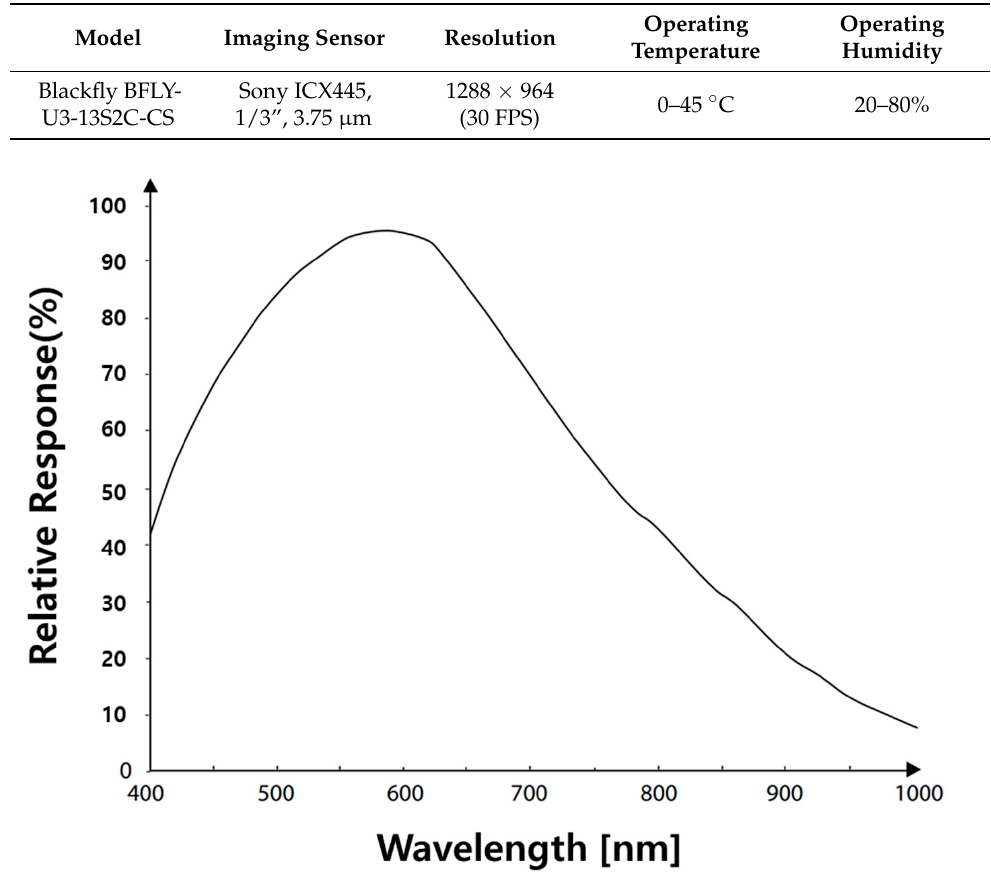
Table 1. Specifications of the Blackfly BFLY-U3-13S2C-CS color camera.